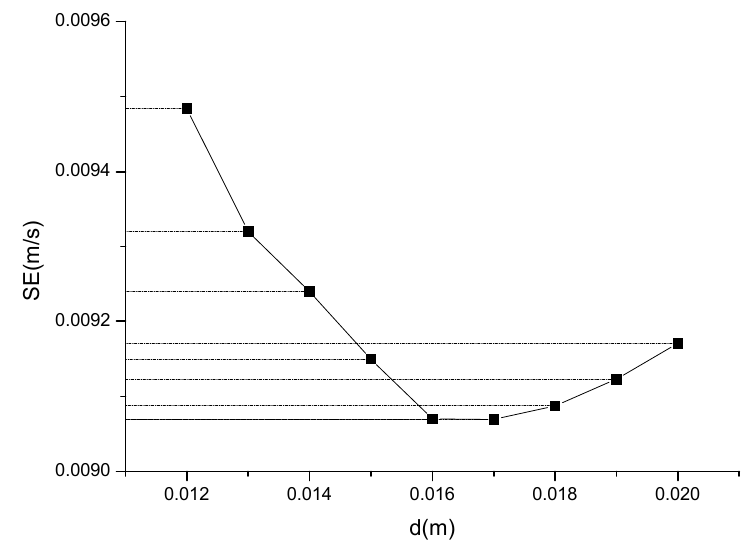
Figure 3. Standard error at various values of d